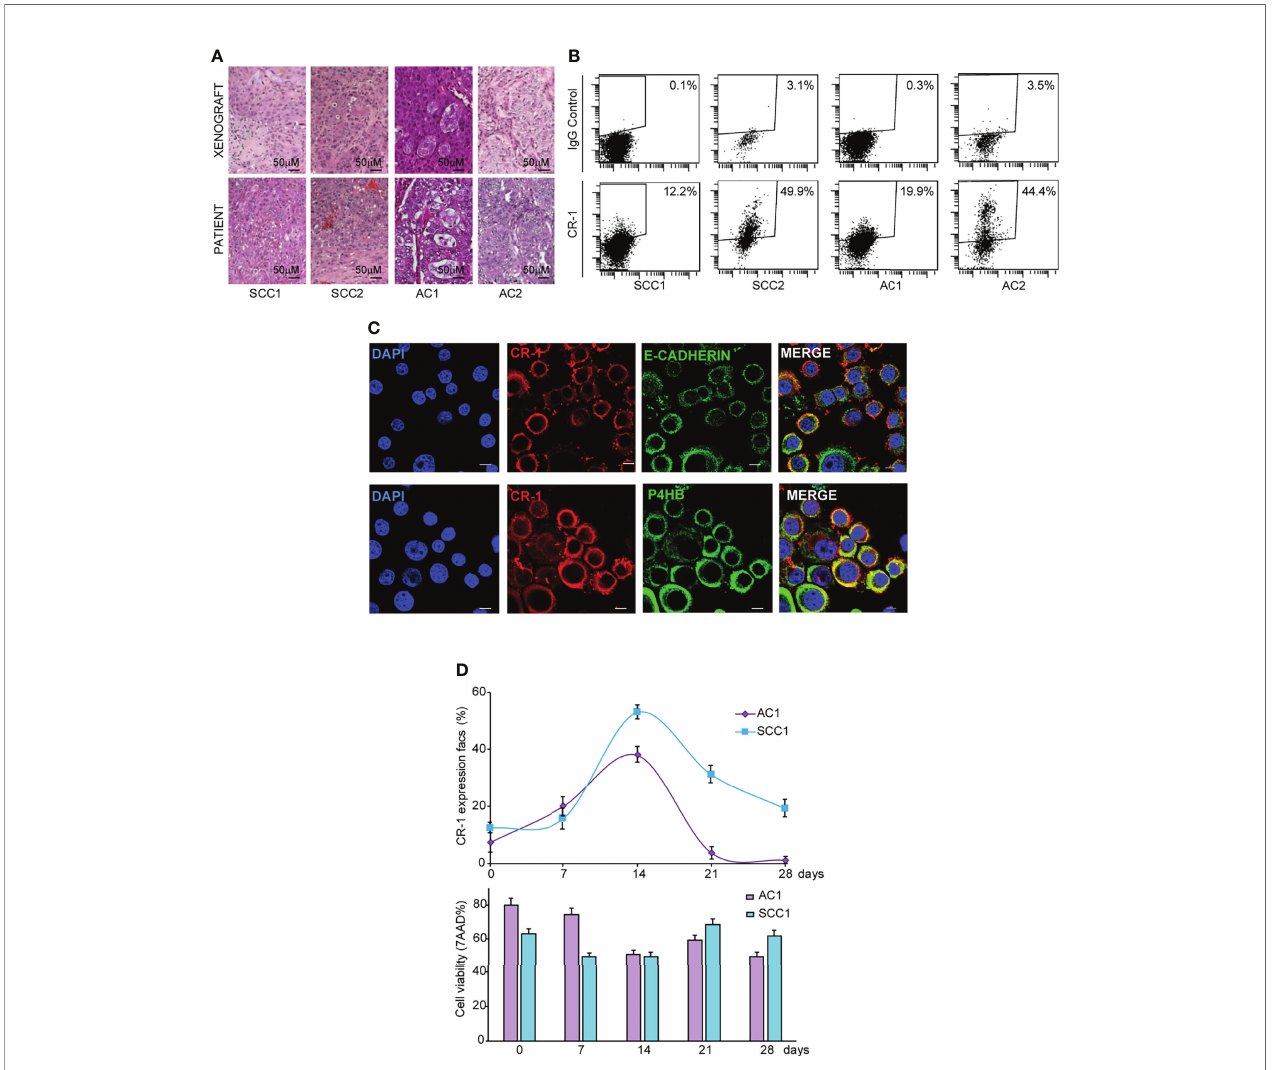
FIGURE 1 | CRIPTO (CR-1) is dynamically expressed in stem cell-enriched cultures of adenocarcinoma (AC) and squamous cell carcinoma (SCC). (A) Hematoxylin/Eosin staining of paraf fi n-embedded xenograft sections obtained from two SCC and two AC spheroid cultures (upper panels) and of the parental patient tumor (lower panels), 20X magni fi cation, scale bar 50 m m. Pictures in the upper panels are representative of xenograft sections derived from three different mice. (B) Flow cytometry analysis of surface CRIPTO expression on two SCC and two AC spheroid cultures derived from patients represented in (A) and in Table S1 . (C) Immuno fl uorescence staining for CRIPTO in combination with E-Cadherin or Prolyl 4-Hydroxylase subunit beta (P4HB) to show respectively plasmamembrane and endoplasmic reticulum localization on AC1 cells, 60X magni fi cation, 1.8X zoom, scale bar 10 m m. (D) Values obtained from fl ow cytometry analysis of surface CRIPTO (indicated as percentage of positive cells) in AC1 (light purple rhombus) and SCC1 (light blue square) at the indicated days. The histogram represents the percentage of FACS-positive cells for 7-amino actinomycin D (7-AAD). FACS plots are shown in Supplemental Figure 1